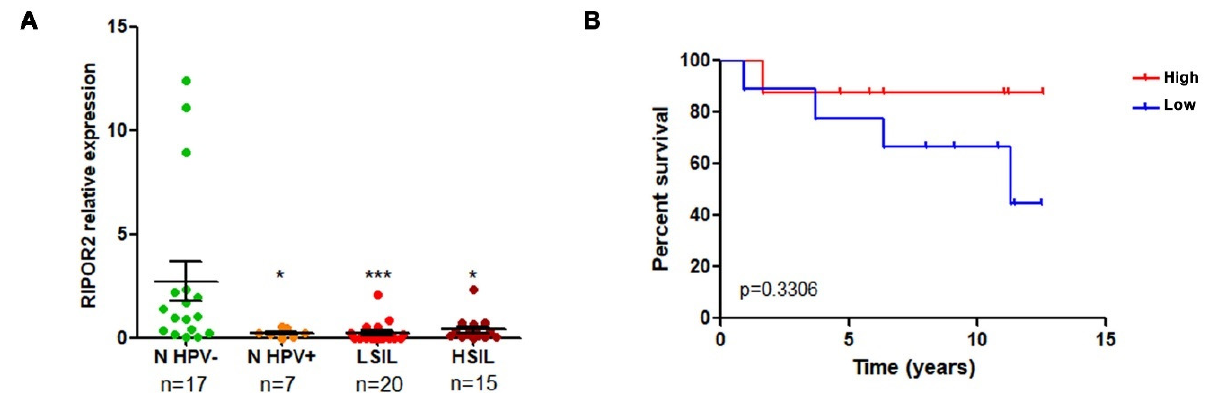
Figure 12. RIPOR2 expression in cervical premalignant lesions and cervical cancer. ( A ) RIPOR2 mRNA levels were analyzed by RT-qPCR using RIPOR2 pool primers in normal ( n ) HPV positive and negative samples, as well as LSIL and HSIL * p ≤ 0.0222; *** p = 0.0001. ( B ) Overall survival analysis comparing RIPOR2 low (blue line) vs. high (red line) expression in cervical cancer patients ( p = 0.3306).